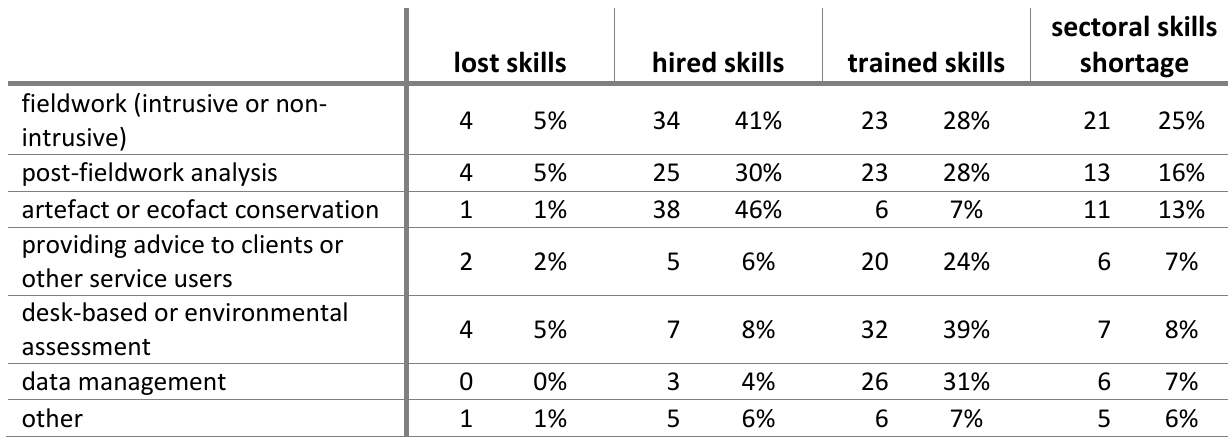
Table 20: Skills that were lost, hired in, trained and where respondents felt there was sectoral shortage in 2020. n =